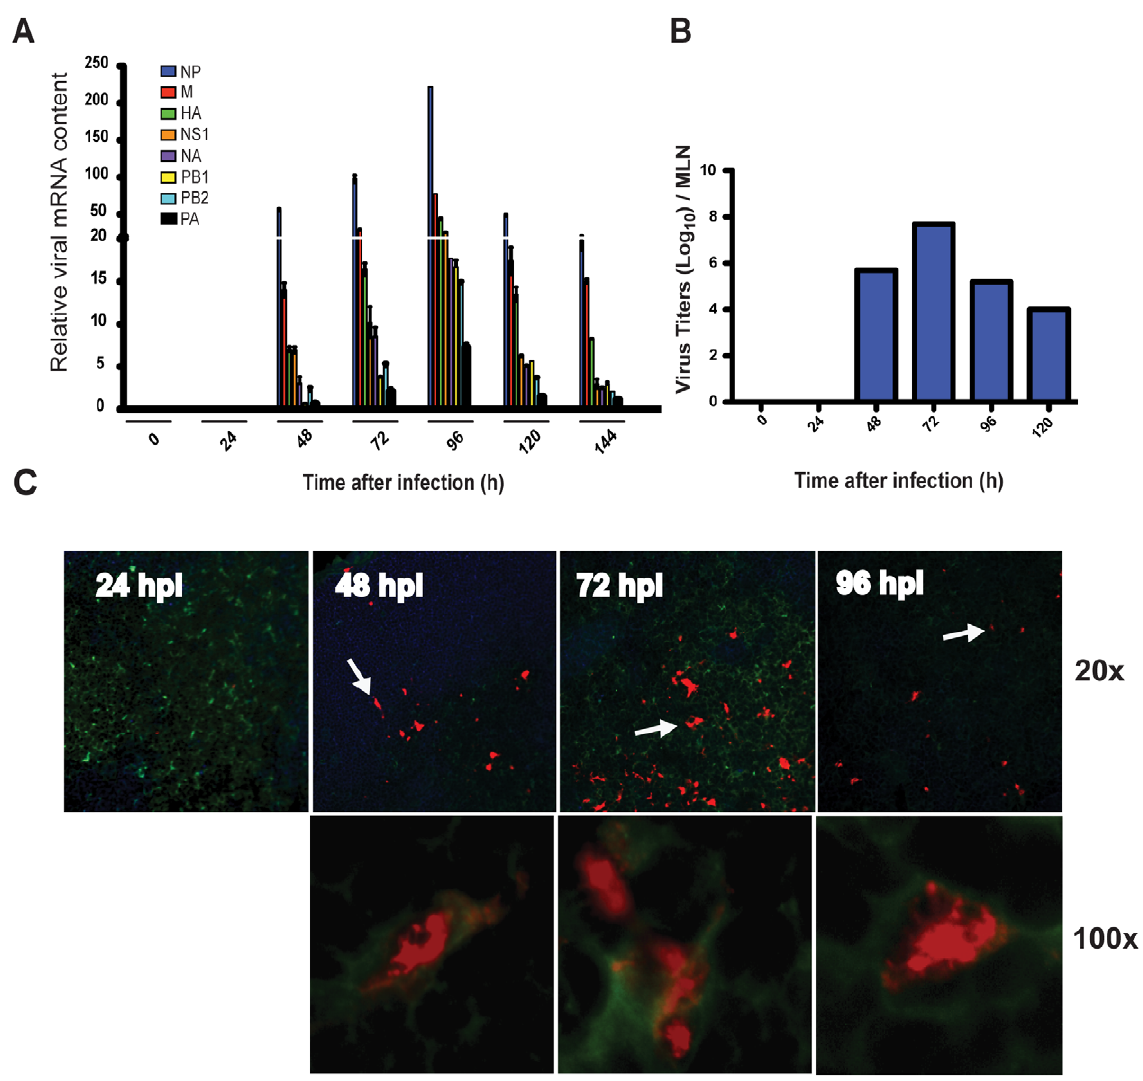
Figure 1. Ag-bearing DC migration is associated with localized viral mRNA and virus replication in the MLNs. A. Total MLN cDNA obtained from PR8-infected mice, at different time points after infection, was analyzed by qPCR for the 8 segments of influenza viral mRNA (NP (nucleoprotein), HA (hemagglutinin), M (matrix protein), NS1 (non-structural protein 1), NA (neuraminidase), PB1 (polymerase PB1), PB2 (polymerase PB2), and PA (polymerase PA) B. MLNs were isolated from PR8-infected mice and titers of infectious virus were determined. C. Cryostat sections of MLNs isolated from PR8-infected mice were fixed, permeabilized and stained for CD11c (green), NP, M (red) and B220 (blue), and visualized with an immunofluorescence microscope at 20x and 100x magnification. White arrows indicate Ag-bearing CD11c + cells at 20x magnification that were then zoomed and photographed at 100x.